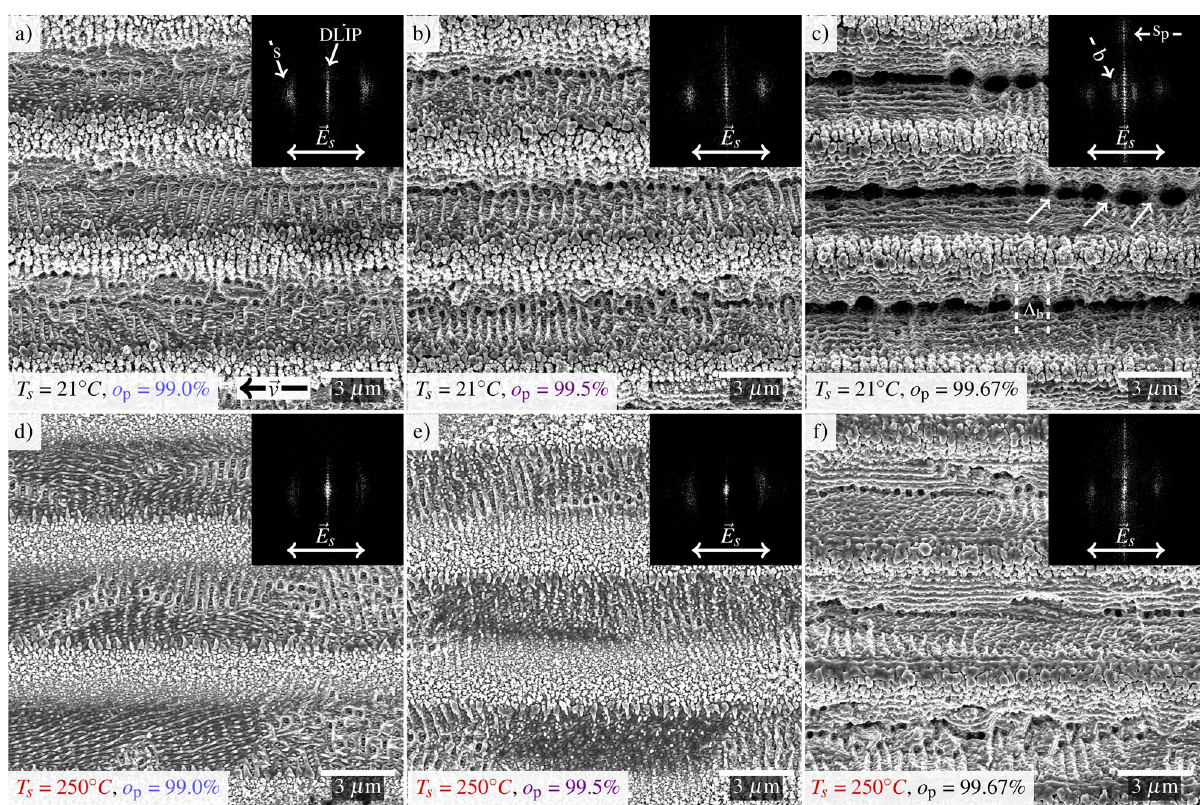
Figure 1. SEM images of the surface structures generated using DLIP. The peak fluence was (cid:31) p = 0.5 J/cm 2 (for Gaussian equivalent without interference) and the repetition rate f = 200 kHz. The sample temperatures, polarization, and overlaps are depicted in the images. The movement of the positioning stage is marked by a black arrow in ( a ). The black insets show the corresponding FFT obtained from a 37.25 37.25 µm SEM image × ( 2 π) − 1 = 200 nm). The process parameters are indicated in each (shown till a wavevector of � k ·